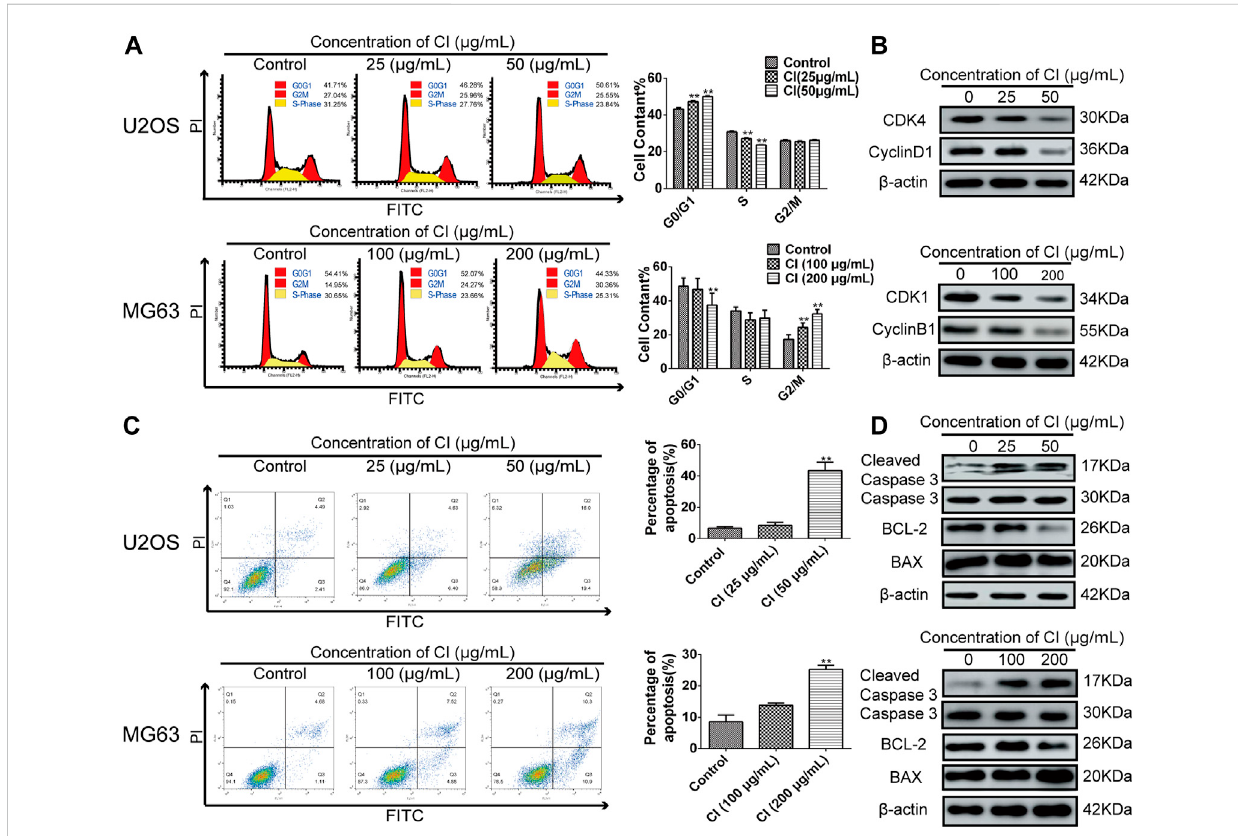
FIGURE 3 CI inducedOS cells cyclearrest and apoptosis. (A) Cell cyclephases ofU2OSand MG63 cells exposed to CI (0,25, 50or 0, 100, 200 μ g/mL) for 12 h analyzed using fl ow cytometry. Results were presented as the mean ± SEM of three independent experiments. * p < 0.05, ** p < 0.01 vs . control group (one-way ANOVA). (B) Levels of expression of CDK4, cyclinD1, CDK1, cyclin B1 were determined using western blot assessment. (C) The stained U2OS and MG63 cells exposed to CI (0, 25, 50 or 0, 100, 200 μ g/mL) for 24 h. Results were presented as the mean ± SEM of three